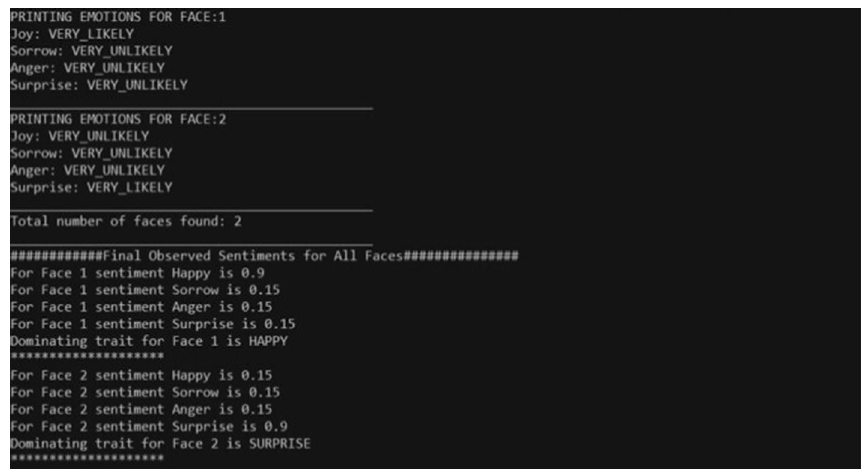
Fig. 15 Snapshot of the response returned by Vision API